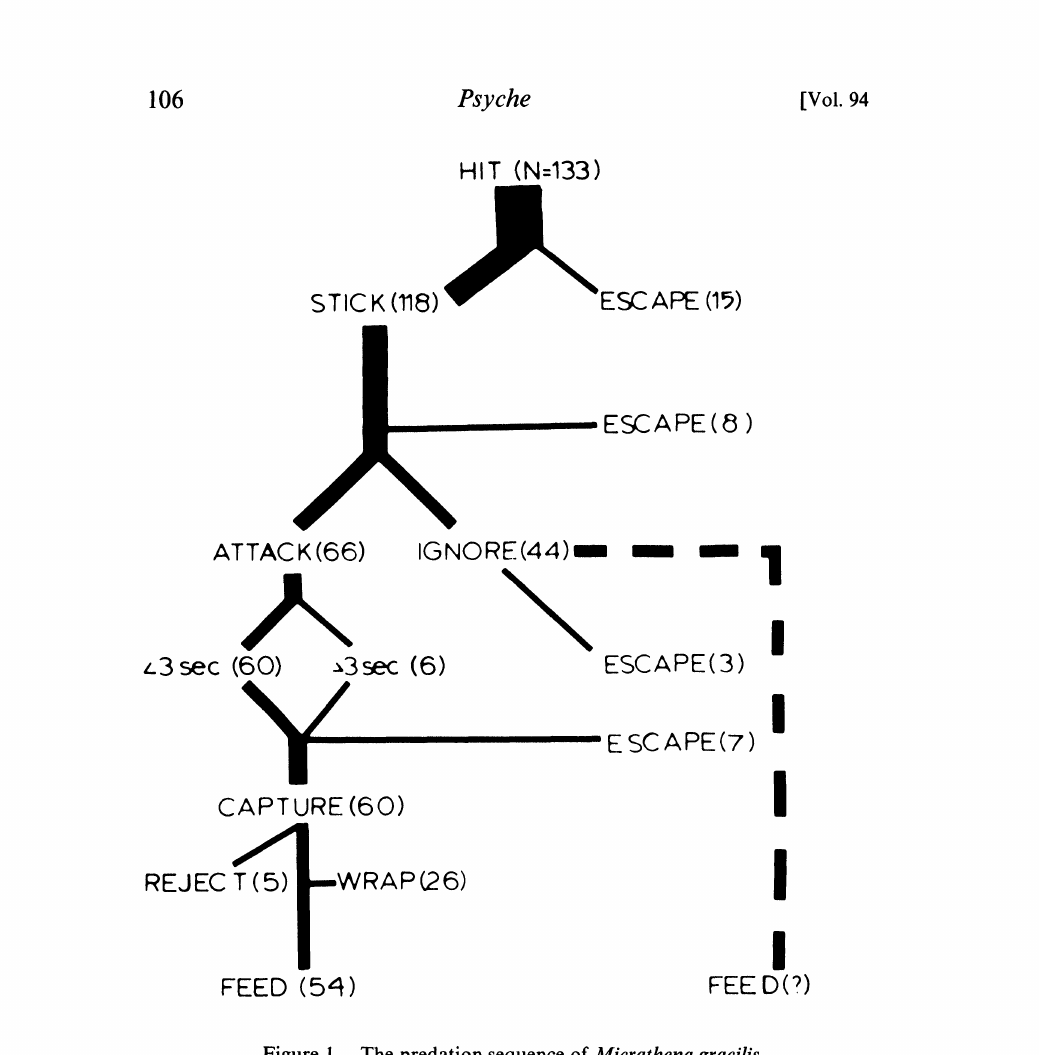
Figure 1. The predation sequence of Micrathena